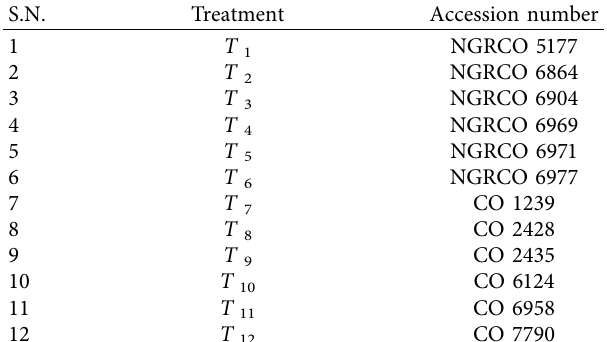
Table 1: List of accessions used in